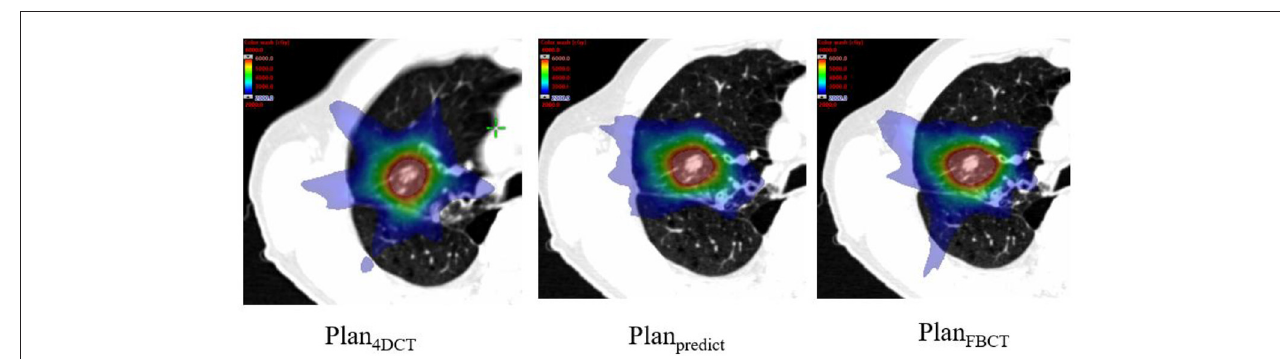
FIGURE 7 | Comparison of color-wash dose distributions of the plans (blue color wash map represents a 20-Gy dose).